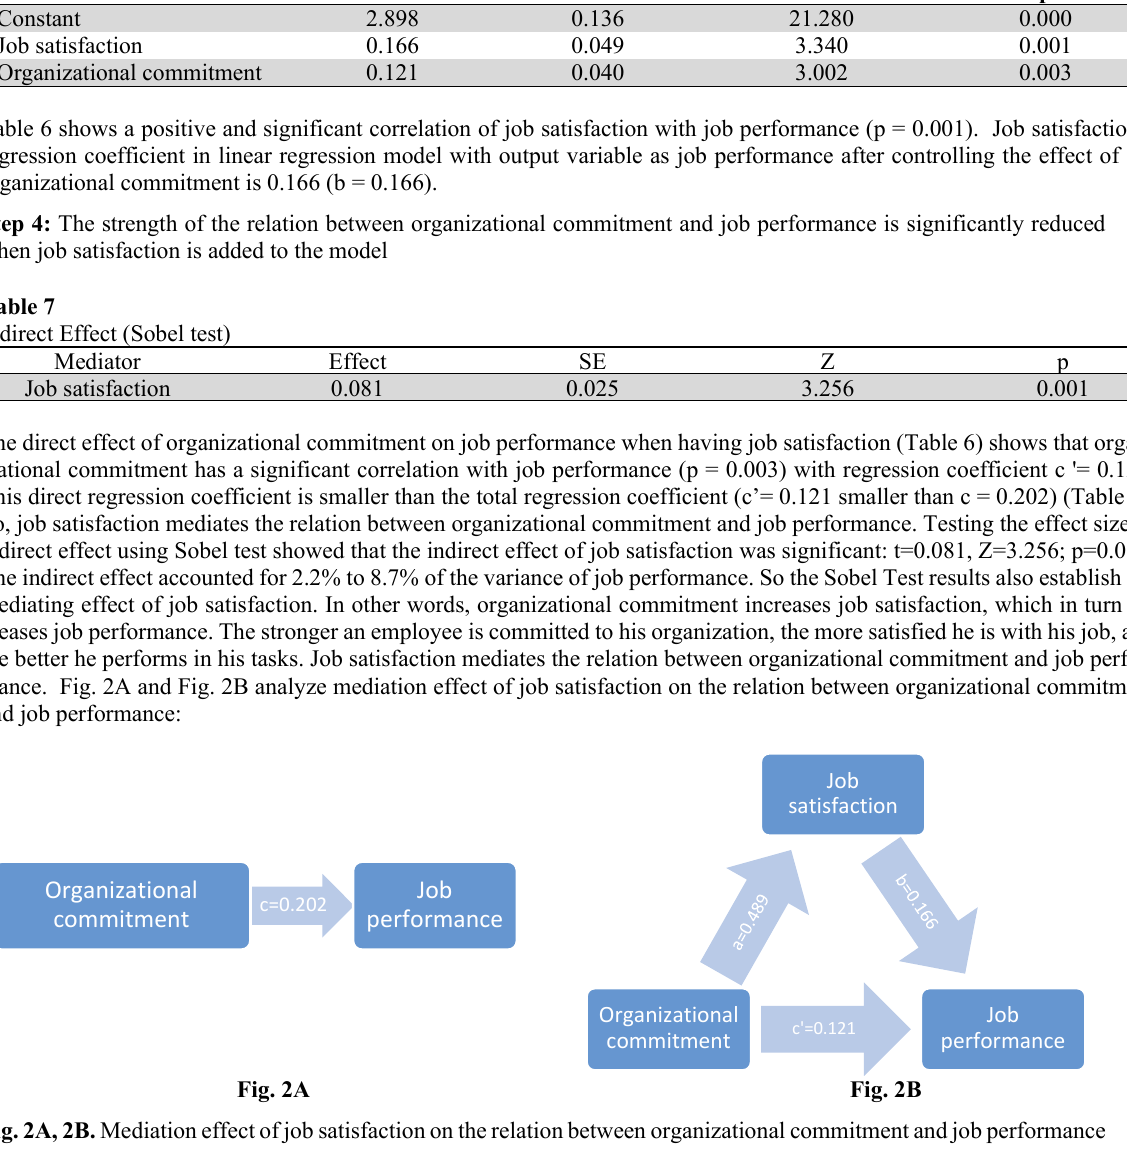
Fig. 2A, 2B. Mediation effect of job satisfaction on the relation between organizational commitment and job performance